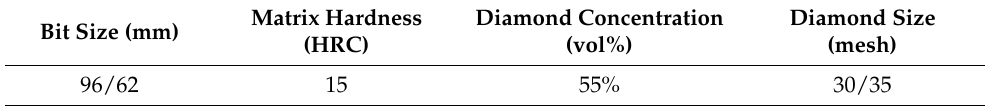
Figure 13. Finished diamond bit products. Table 5. Diamond bit parameters.